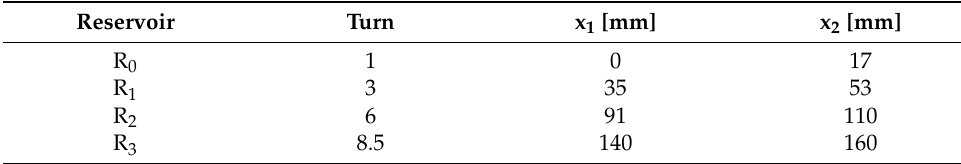
Table 1. The lateral coordinates of the reservoirs before rolling.